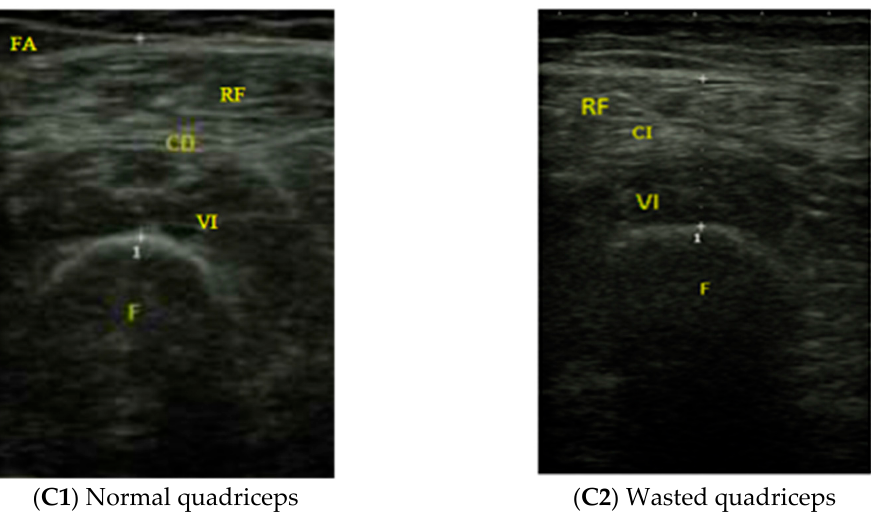
Figure 1. Ultrasound images. ( A ) Masseter muscle (A1 normal and A2 wasted). A1 (normal masseter muscle), A2 (wasted masseter muscle), (M: masseter muscle; MD: right jaw; MI left jaw); ( B ) Biceps brachii (B1 normal and B2 wasted). B1 (normal bíceps brachii), B2 (wasted bíceps brachii), (H: humerus; B: Biceps); ( C ) Quadriceps femoris (C1 normal C2 wasted). C1 (normal quadriceps RF-VI), C2 (wasted quadriceps RF-VI), (FA: subcutaneous celular tissue; RF: rectus femoris; VI: vastus intermedius; F: femoris CD: right quadriceps humerus; B: Biceps).